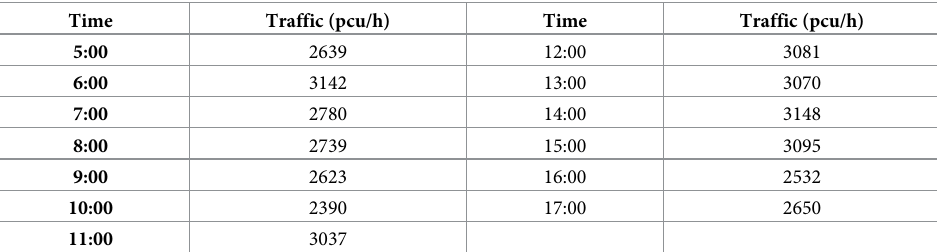
Table 1. Traffic flow at Changyi